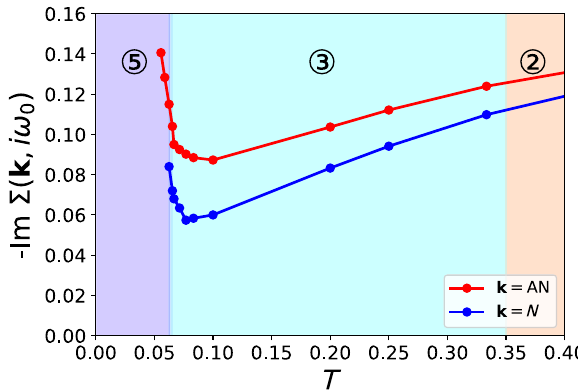
FIG. 23. Diagnosing non-Fermi-liquid behavior: The imagi- nary part of the self-energy at the first Matsubara frequency calculated by DiagMC for the nodal and antinodal points displays the deviation from linearity as a function of T (see